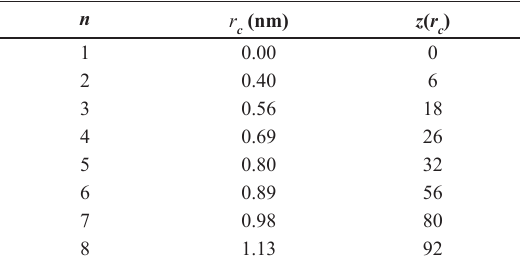
. Table 4. Values of n , r 3